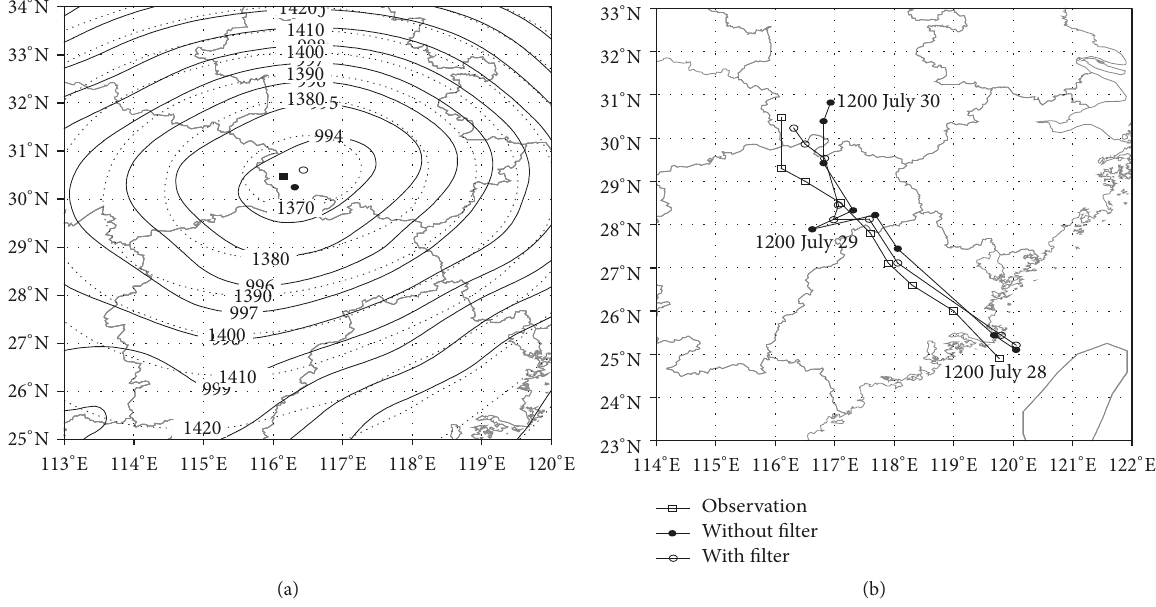
Figure 3: (a) The simulated sea level pressure (solid line, unit hPa) and 850 hPa geopotential height (dotted line, unit gpm) filtered by Barnes filter at 1200 UTC 30 July 2008, and the filled (open) circle indicates the TC center determined by lowest SLP (geopotential height) while the filled square represents the observed TC center. (b) The observed track (observation), the track determined by SLP with Barnes filter (with filter), and the track determined by SLP without Barnes filter (without filter) for TC Fung-Wong after landing China